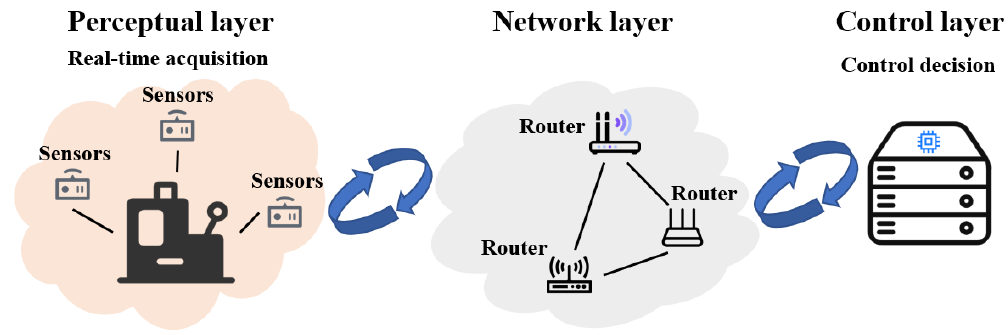
Figure 1. CPS system structure.